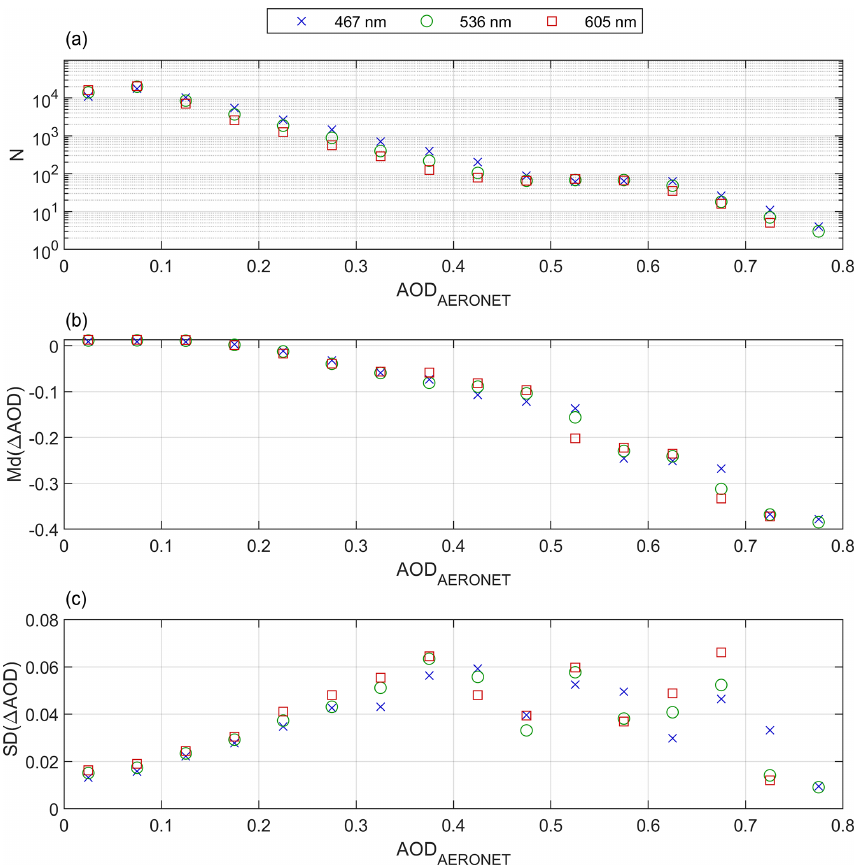
Figure 18. Median (Md; b ) and standard deviation (SD; c ) of the (cid:49) differences in the aerosol optical depth (AOD) retrieved by GRASP with the multi-pixel approach (GRASPmp-CAM) and those obtained by AERONET at 467, 536 and 605nm for different AOD bins. The available number of (cid:49) AOD data (N) per AOD bin is also shown in (a) for the three